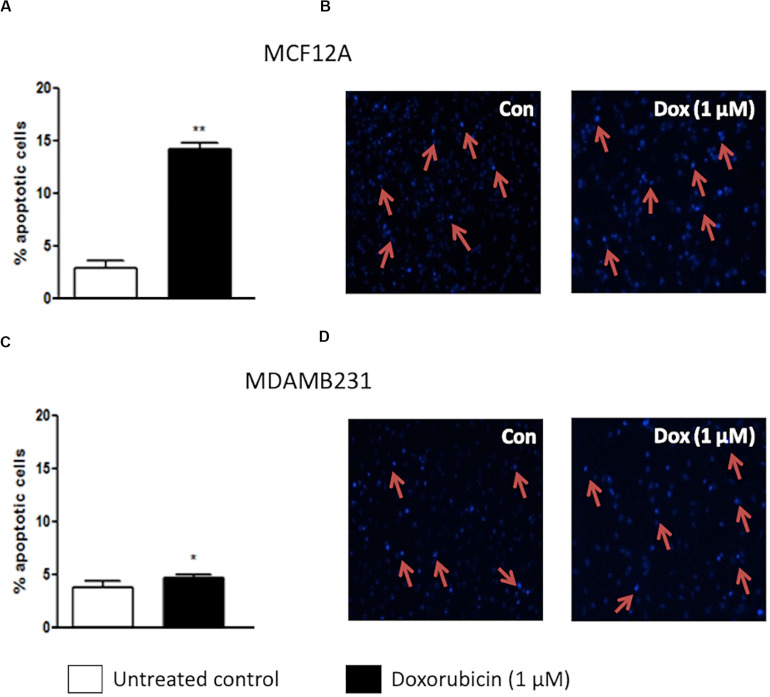
Percentage apoptotic cells in MCF12A and MDAMB231 cultures. (A) Bar graph indicating the percentage of nuclei that represents morphological changes characteristic of apoptosis in MCF12A cells, (B) representative image of MCF12A cells stained with Hoechst, (C) bar graphs indicating the percentage of nuclei that represents morphological changes characteristic of apoptosis in MDAMB231 cells, and (D) representative images of MDAMB231 cells stained with Hoechst. Red arrows demonstrate apoptotic nuclear features. Each value represents the mean ± SEM of at least three independent determinations. Con, control; *p < 0.05; **p < 0.01.